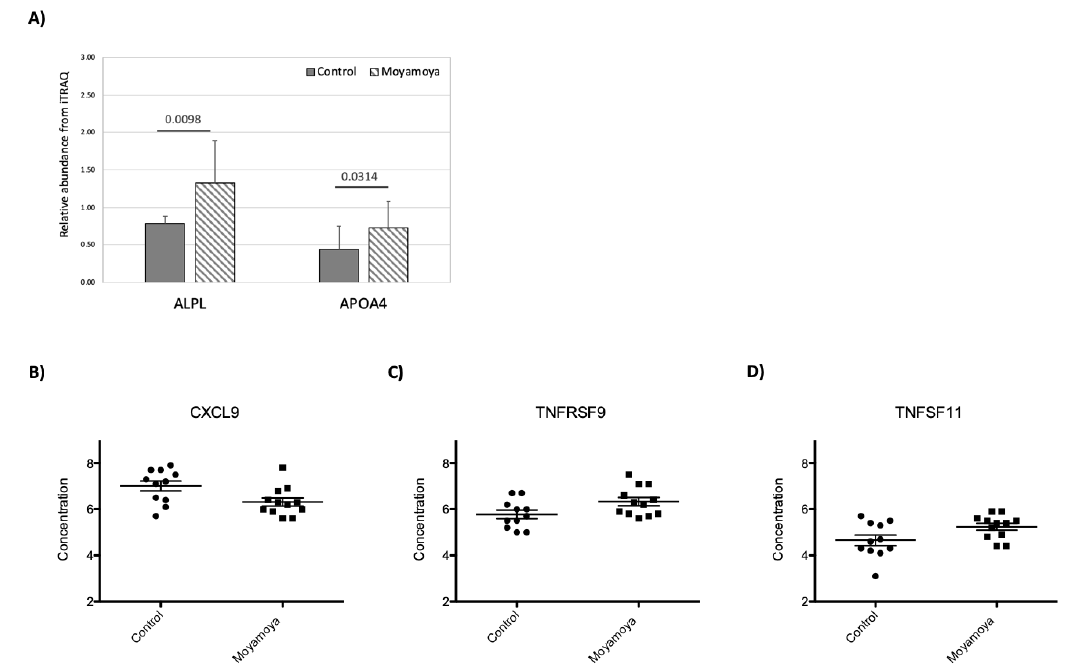
Figure 4. Concentration changes of plasma proteins associated with MMD measured by isobaric tags for relative and absolute quantitation (iTRAQ) ( A ) or proximity extension assay (PEA) ( B – D ). For iTRAQ, the protein identities are indicated on the X-axis, the p -values and sample groups are indicated on top of the bar graph. For PEA data, sample groups are indicated on the X-axis and the protein abundance is indicated on Y-axis. The protein identity is indicated on top of the figures.